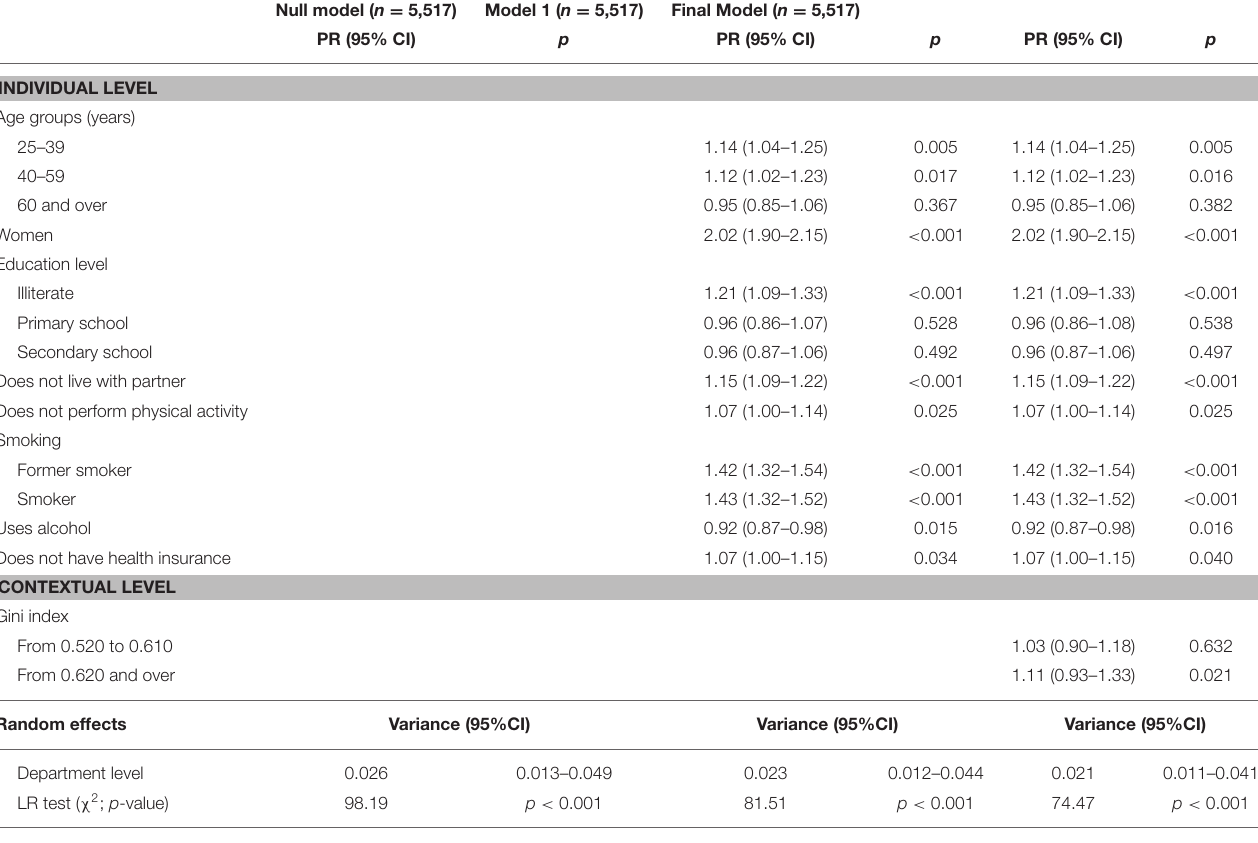
TABLE 4 | Multilevel poisson regression analysis for the outcome “Decreased vital energy and somatic symptoms” in the Brazilian National Health Survey